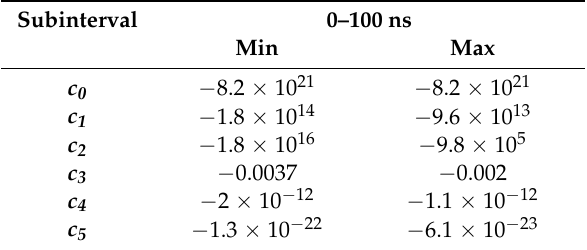
Table 3. Ranges of c 0 , c 1 , c 2 , c 3 , c 4 , and c 5 during (0, 100 ns) under Design